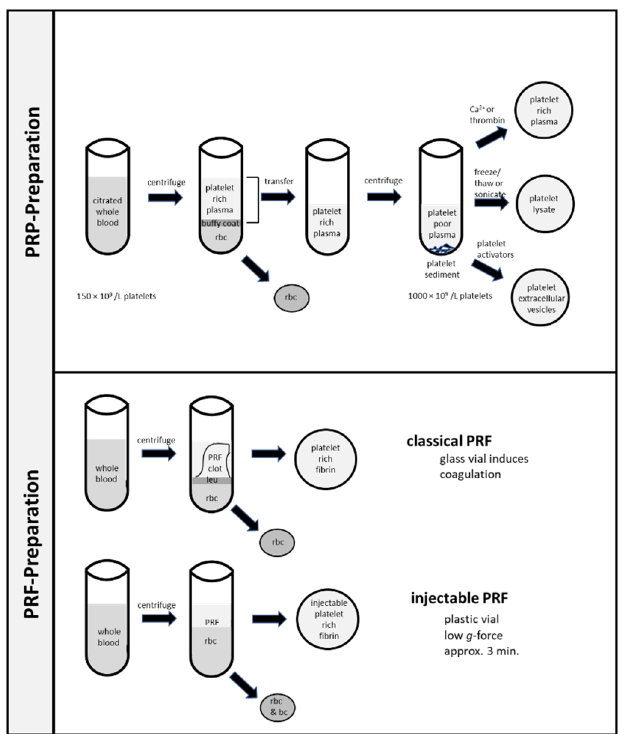
Figure 3. Methods for the preparation of platelet-rich concentrates. Initial steps for the preparation of platelet-rich plasma, platelet-rich lysate, and platelet vesicles are identical. Note, that both classical platelet-rich fibrin and injectable platelet-rich fibrin can be obtained by a single centrifugation without the necessity of anticoagulation; leu: leukocytes; rbc: red blood cells; bc: buffy coat.